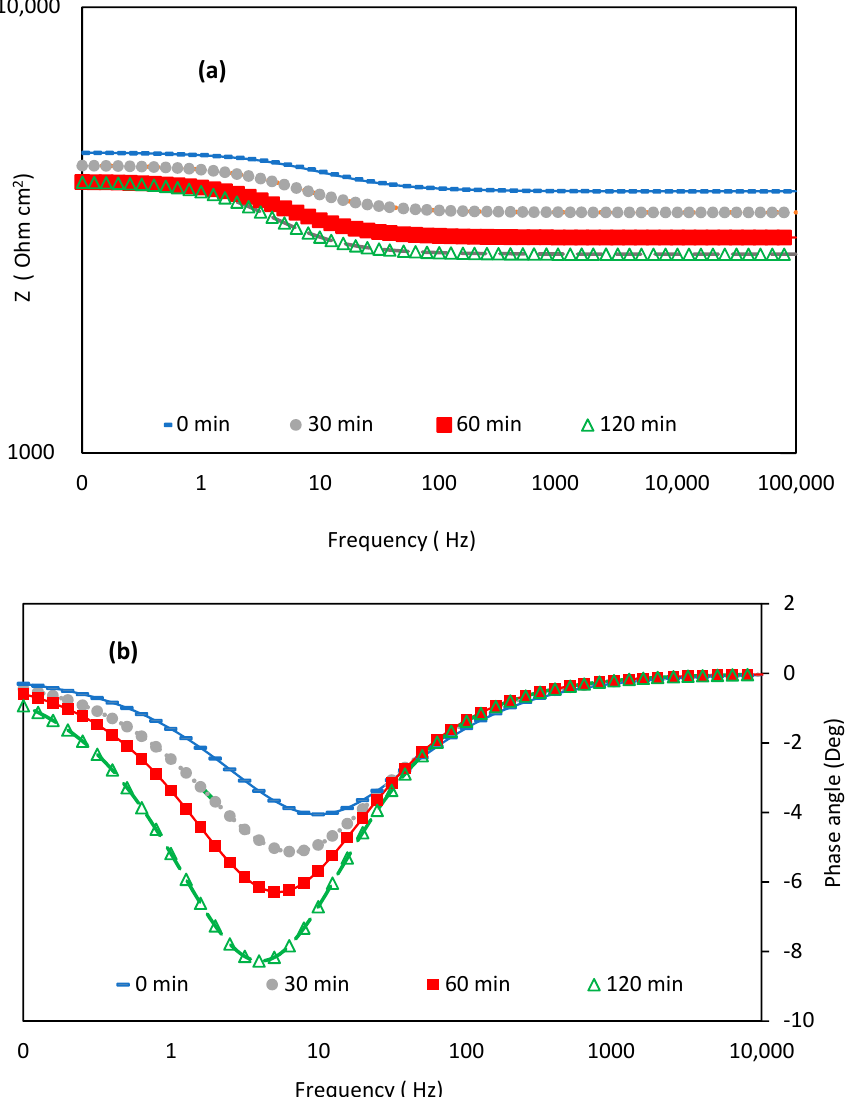
Figure 9. Bode plots of ( a ) phase angle vs frequency, and ( b ) modulus vs frequency. for API X-120 steel alloy in GTL process water at different immersion times.